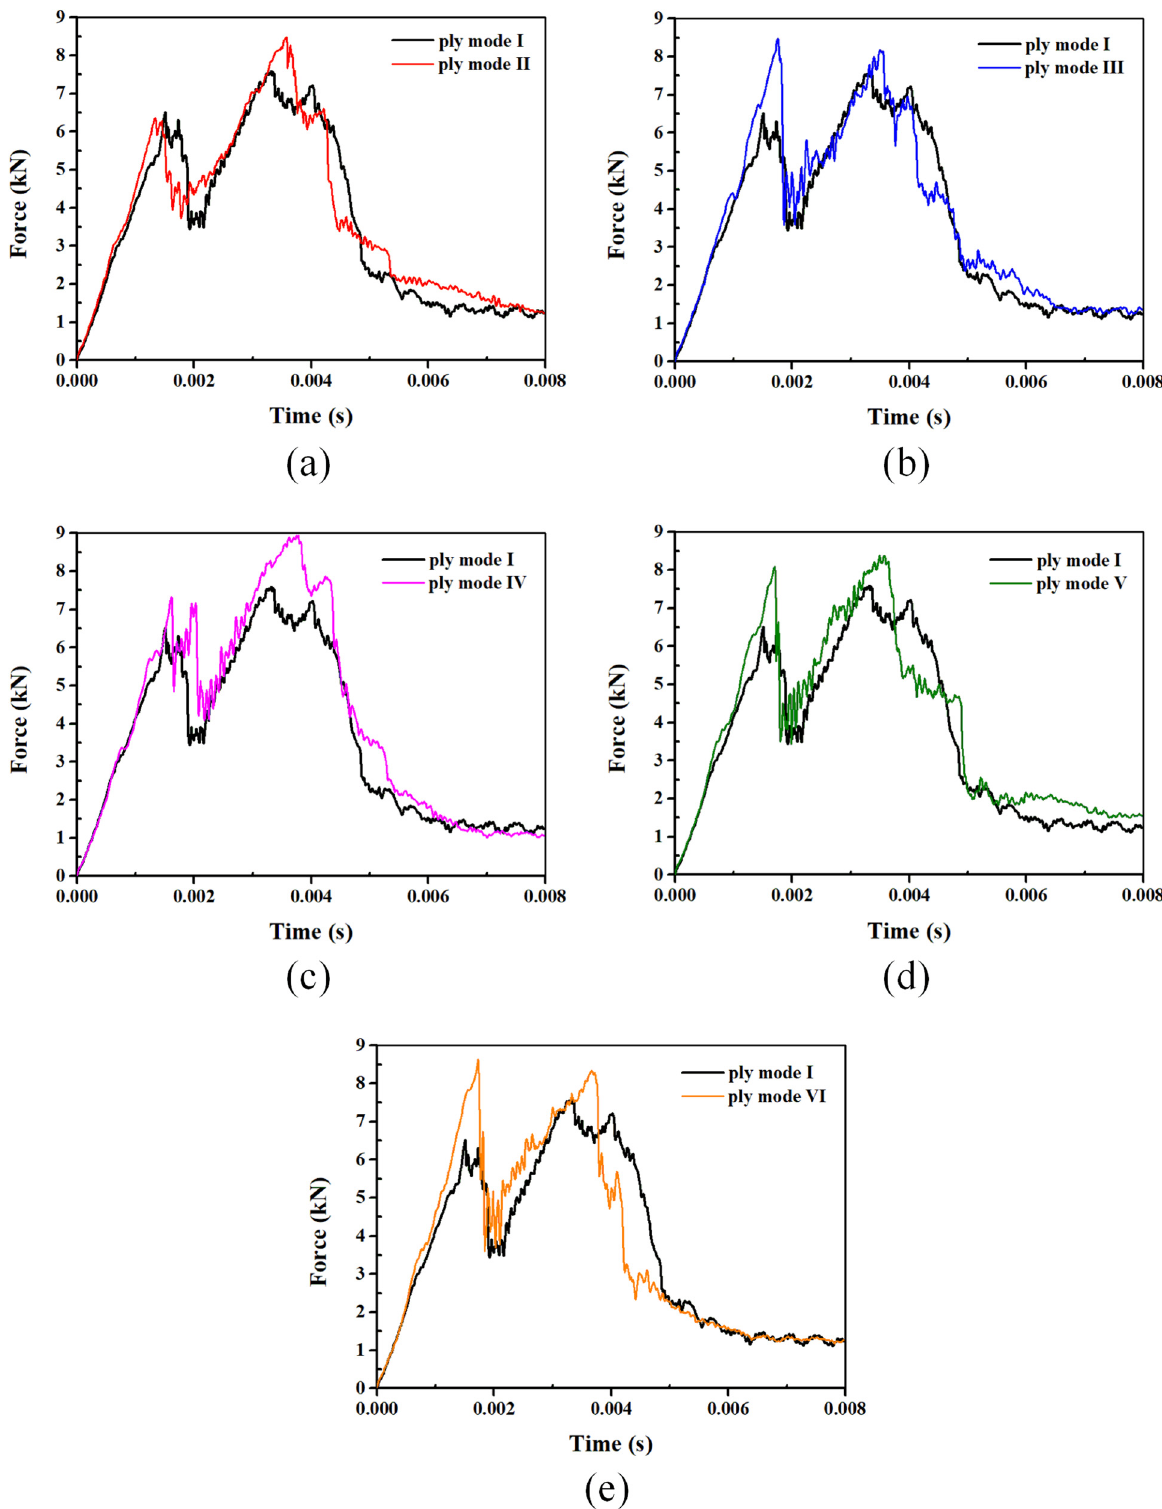
Figure 7: Typical contact force versus time curves. ( The comparison of ply mode II and ply mode I ( a ) , ply mode III and ply mode I ( b ) , ply mode IV and ply mode I ( c ) , ply mode V and ply mode I ( d ) , ply mode VI and ply mode I ( e ))